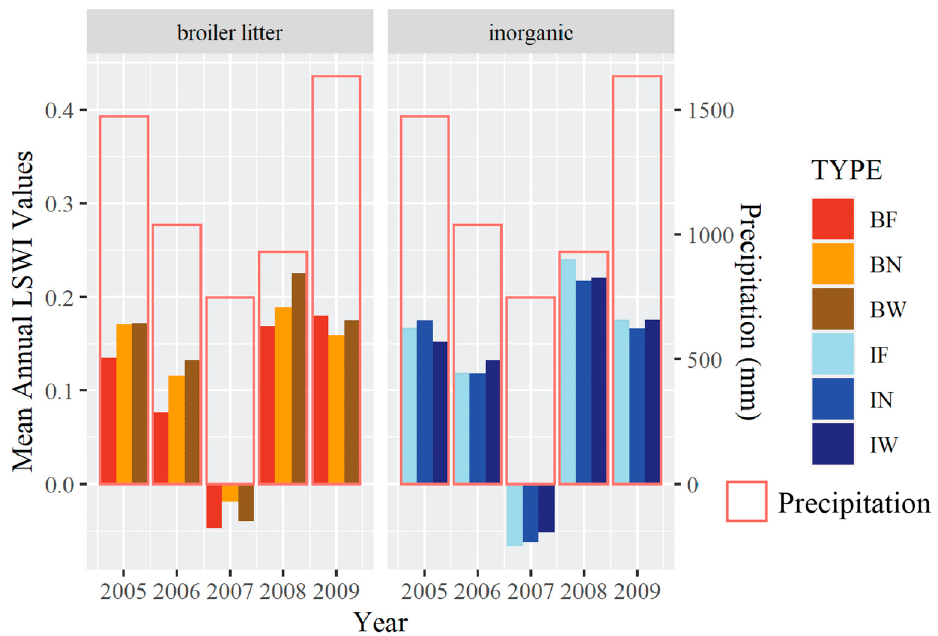
Figure 8. Bar chart of mean annual land surface water index (LSWI) values across all study years. There is no significant ( p > 0.05) difference within single year values across treatments. B: Broiler litter; I: Inorganic fertilizer; F: Endophyte-free; N: Novel endophyte; W: Wild endophyte.